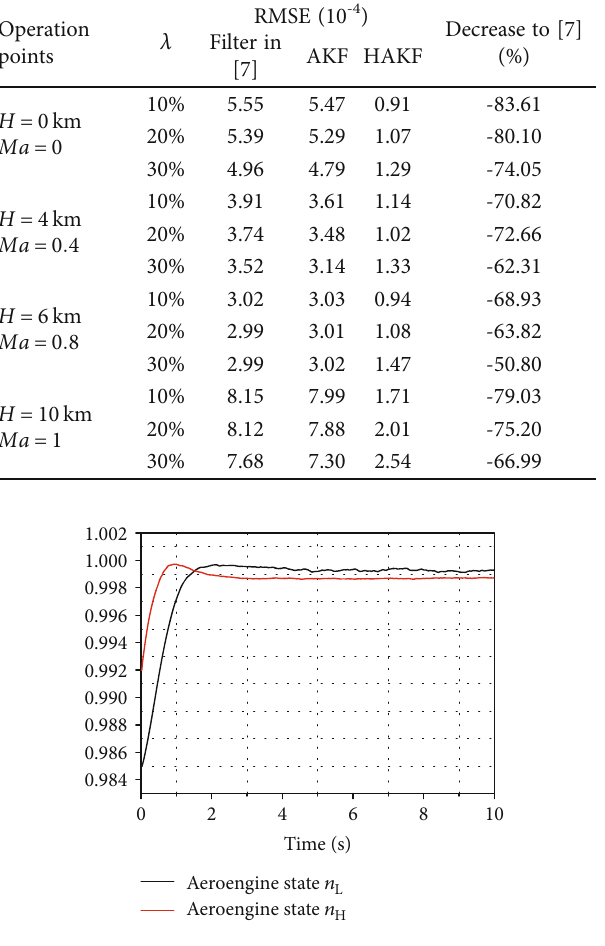
n Figure 15: States n L and H stabilization history of control system with λ = 10 % .